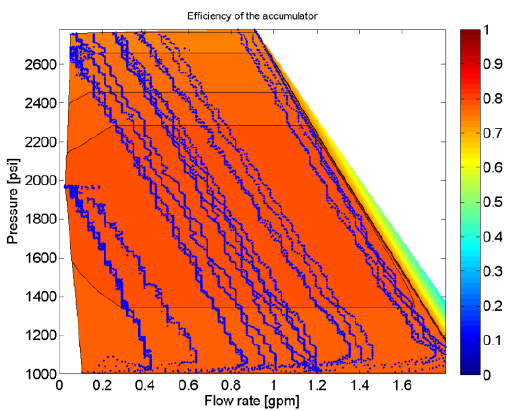
Figure 14. Instantaneous efficiency of the hydraulic accumulator with data points.